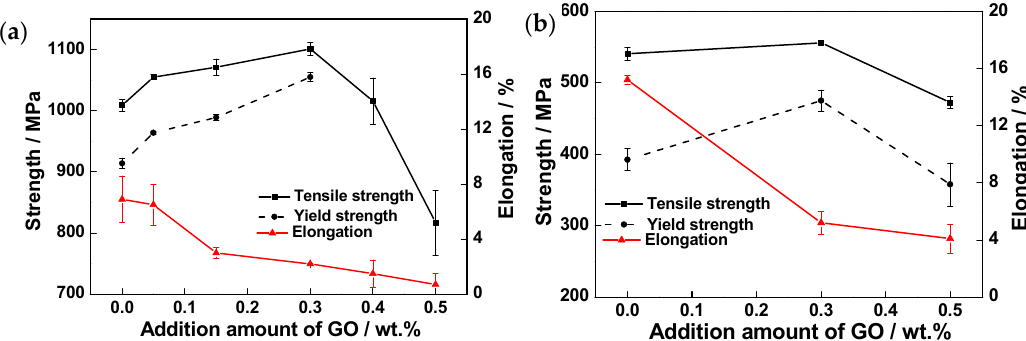
Figure 11. Tensile properties of the composites at different temperatures. ( a ) Room temperature; ( b ) 600 °C.